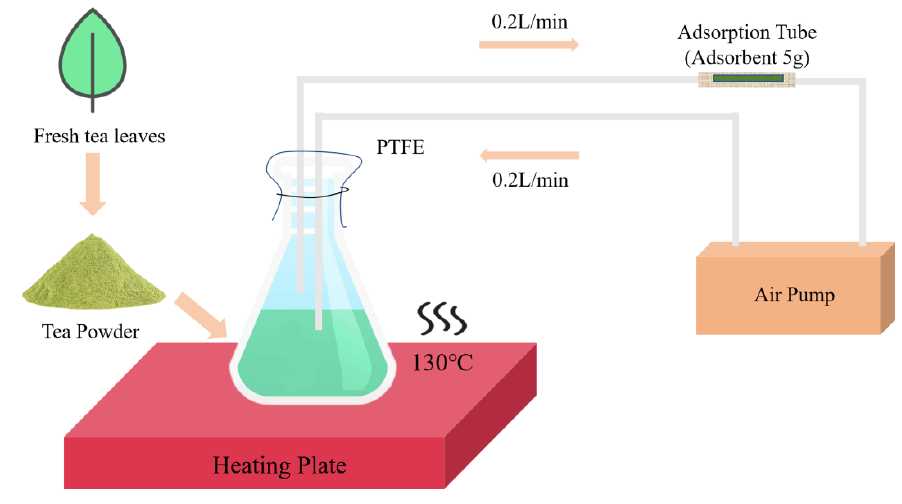
Figure 10. Simplified sampling process.